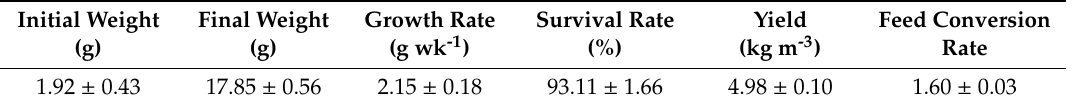
Table 3. Production performance of L. vannamei cultured in the biofloc-RAS for a 70-day trial (mean ± S.D., N = 3).